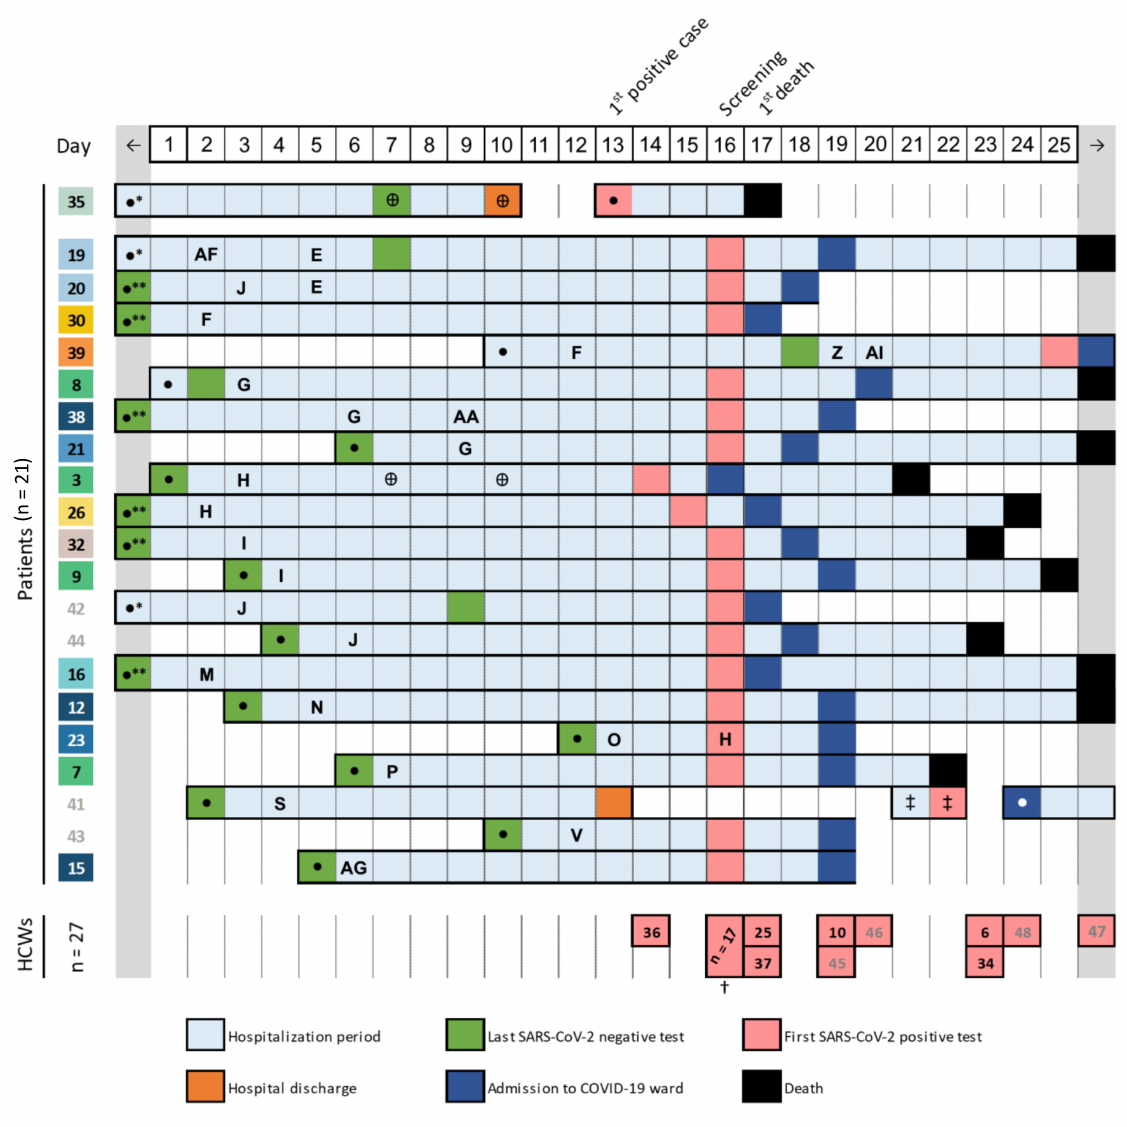
Figure 1. Timeline of events during the SARS-CoV-2 nosocomial outbreak. The figure summarizes the main events occurring during the study period, in which day 1 corresponds to the first day of the 15-day period before the large screening. It depicts the day of hospital admission ( • ), rooms transfer, sample collection for the last negative SARS-CoV-2 test ( green ), sample collection for the first positive test ( pink ), transfer to the COVID-19 ward ( dark blue ) and clinical outcome (death ( black ), hospital discharge ( orange )) for each of the 21 infected patients. The patient numbers are colored according to the phylogenetic reconstruction (as in Figure 2A), where numbers colored in grey indicate samples for which virus genome data could not be obtained. To facilitate the identification of patient-to-patient contact, patient timelines (rows in the figure) are grouped by room (identified by capital letters, see Figure S1). The hospitalization days are highlighted in light blue and the room numbers are indicated on the day a given patient was transferred to that room (the room stay extends until a new transfer appears on the timeline). With the exception of patient 35 (Ward A), all patients and room numbers are relative to Ward B. The presence in other hospital areas is also indicated when relevant (Hemodialysis ( ⊕ ), Emergency department ( ‡ )). The date of sample collection for healthcare workers (HCWs) testing positive is also presented at the bottom. The timeline presented starts two weeks before the large test screening and extends until the date of sample collection of the last outbreak-related positive case. Light grey fields (on both sides of the timeline) are included to show events occurring outside the study timeline. ( † ) List of HCWs with a positive test on large screening: 1,2,4,5,11,13,14,17,18,22,24,27,28,29,31,33 and 40 (no sequencing data). ( * ), Patient admission before study period; ( ** ), Patient admission and last negative test before the study